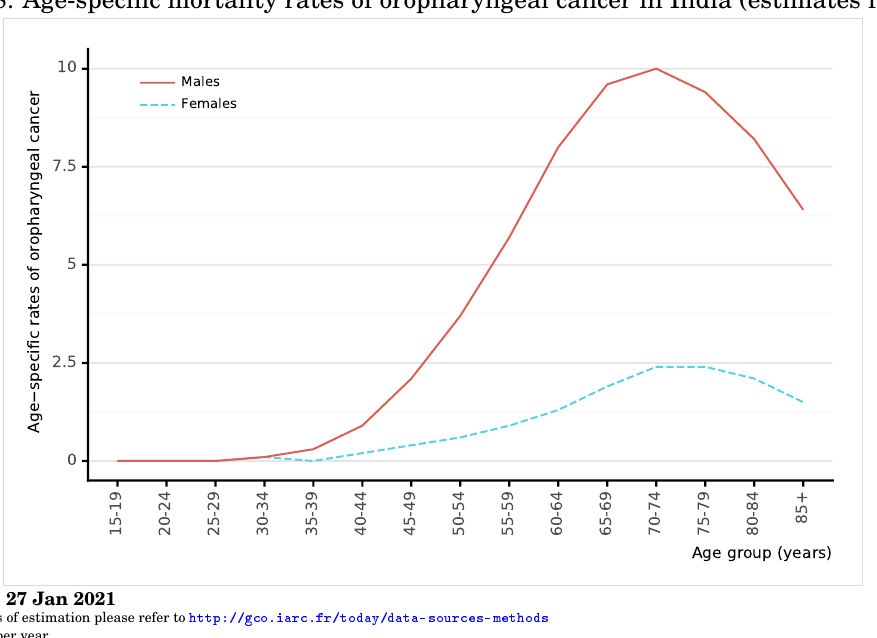
Figure 38: Age-specific mortality rates of oropharyngeal cancer in India (estimates for 2020)